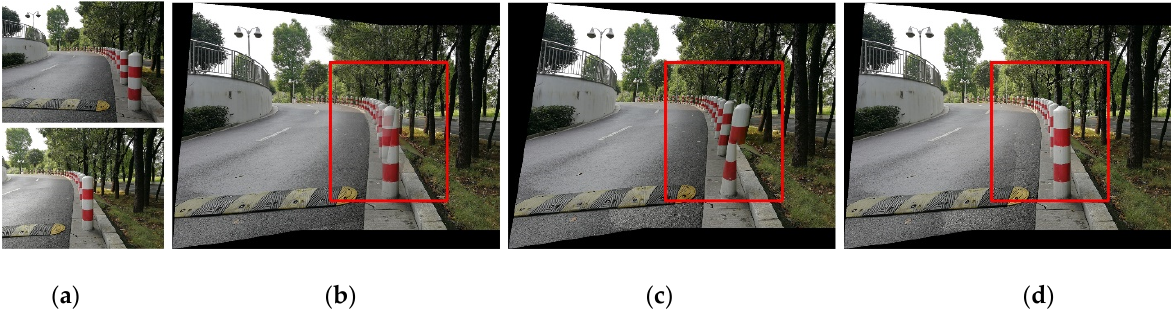
Figure 1. Failure cases of two types of stitching method. ( a ) Two images to be stitched. ( b ) Image stitching result of the method in [13]. ( c ) Image stitching result of the method in [18]. ( d ) Image stitching result of the proposed method.